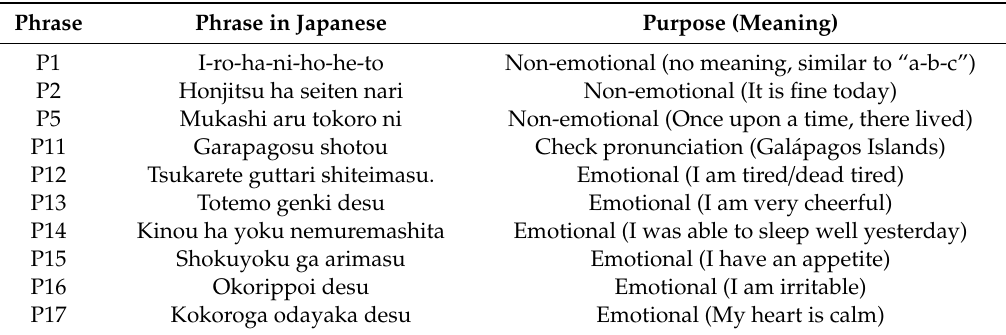
Table 1. Ten phrases used for recording.